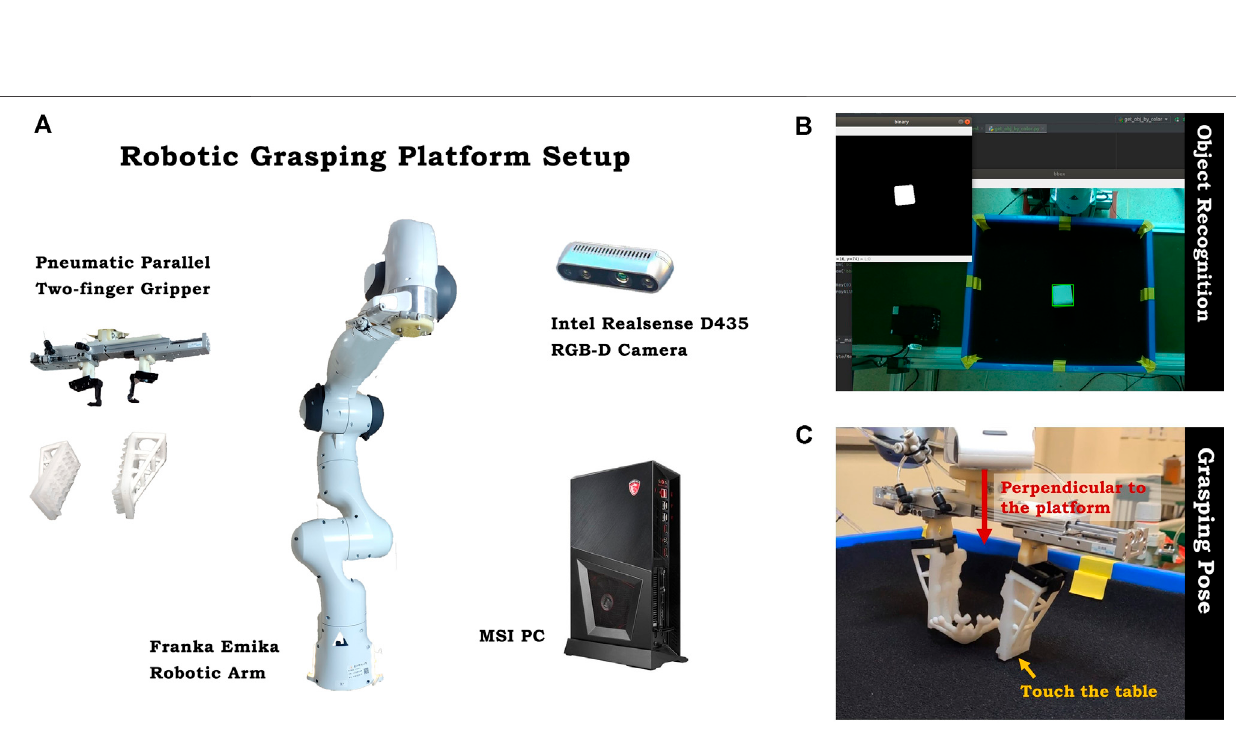
Frontiers in Robotics and AI |